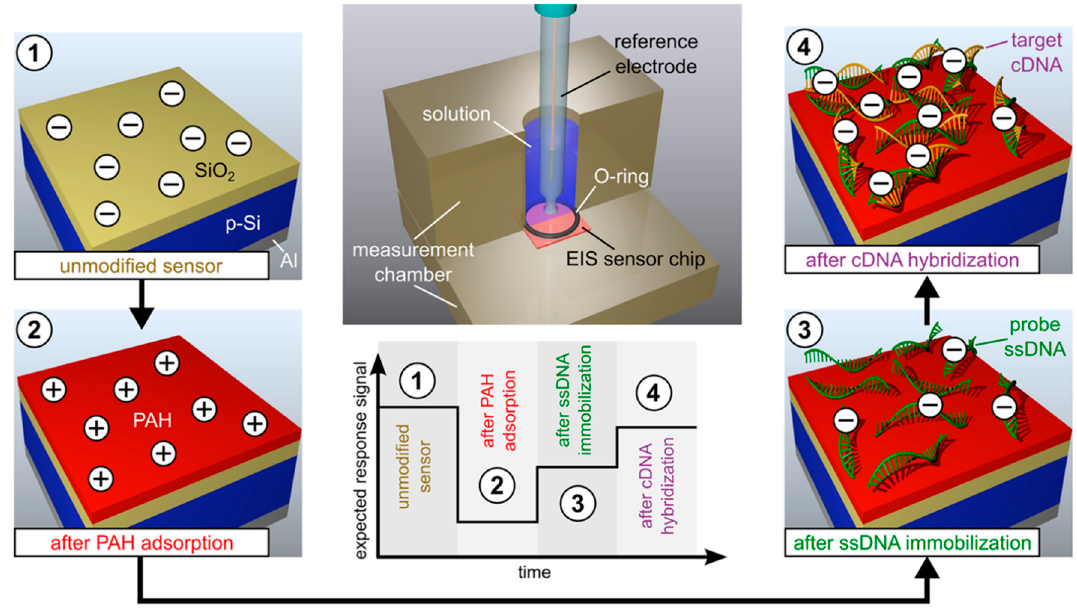
Figure 5. Modification steps of the EIS sensor, measurement setup (middle column, top), and expected ConCap response (middle column, bottom). ( 1 ) Unmodified sensor, ( 2 ) after poly(allylamine hydrochloride) (PAH) adsorption, ( 3 ) after single-stranded DNA (ssDNA) immobilization, and ( 4 ) after complementary target DNA (cDNA) hybridization. + and − symbols indicate the respective surface charges. Reproduced from Ref. [144] with permission of the American Chemical